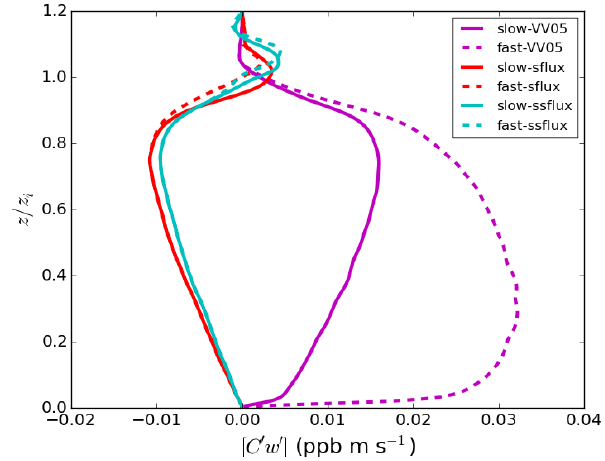
Figure 3. Vertical profiles of the horizontally averaged vertical flux of tracer C [ C (cid:48) w (cid:48) ] with homogeneous emissions for varied cases time averaged for the last 30min of the simulations.